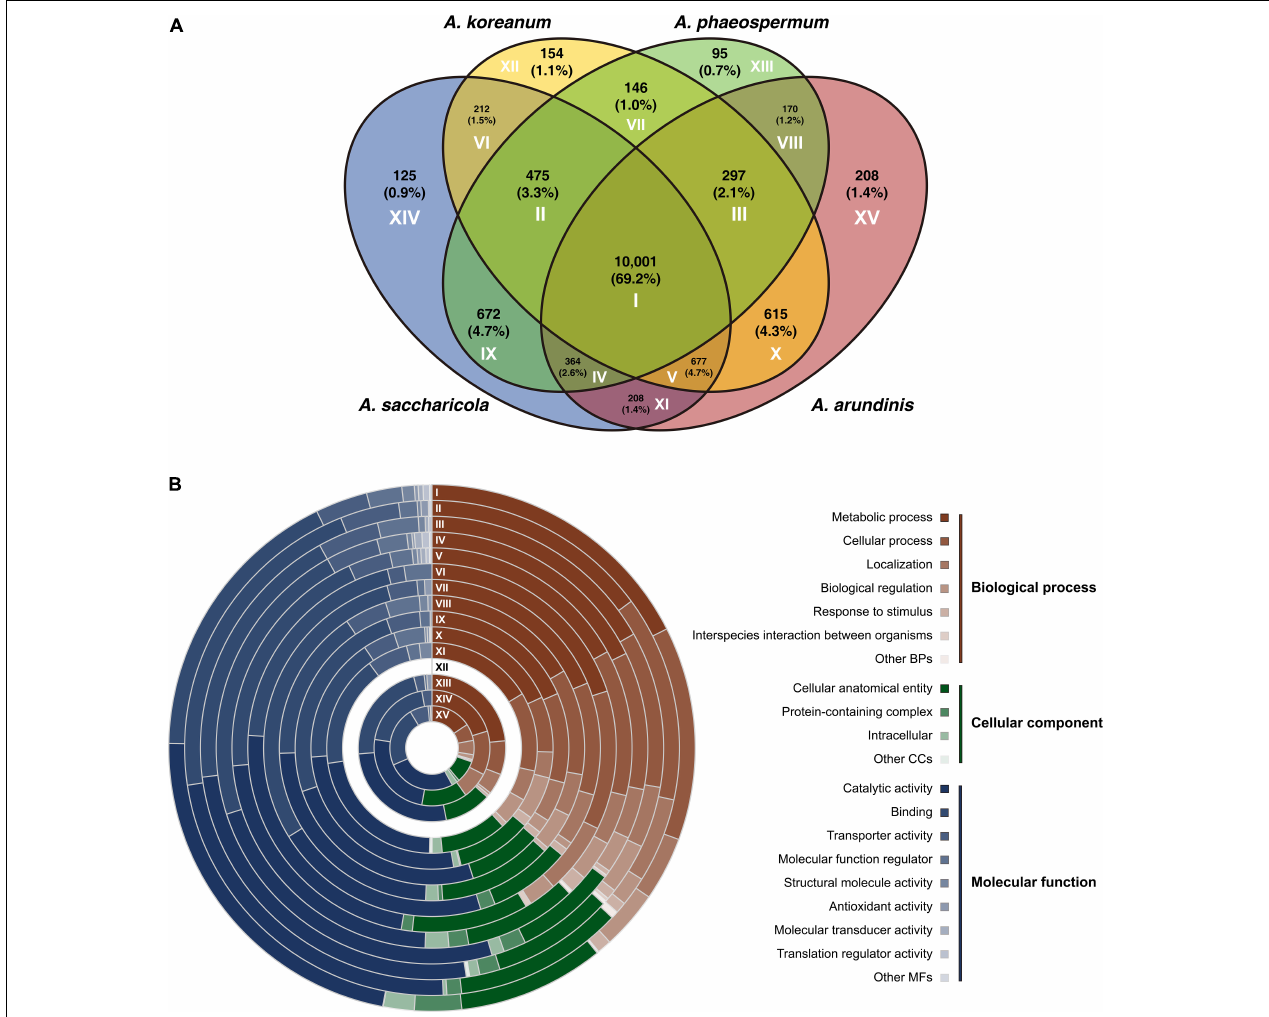
FIGURE 1 | Genome comparison between Arthrinium koreanum , A. saccharicola , A. phaeospermum , and A. arundinis . (A) Venn diagram showing the number of shared and specific gene orthologs. (B) Compositions of gene families according to gene ontology categories. Circles I-XV correspond to areas with same Roman numerals in panel (A)